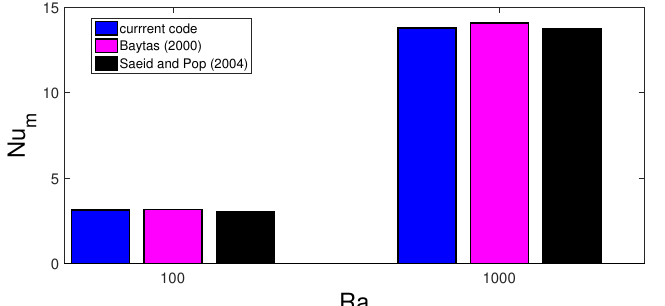
Figure 3. Code validation 1: Average Nu comparisons of convection in a differentially heated cavity for different Ha at Grashof number of 2 × 10 5 .